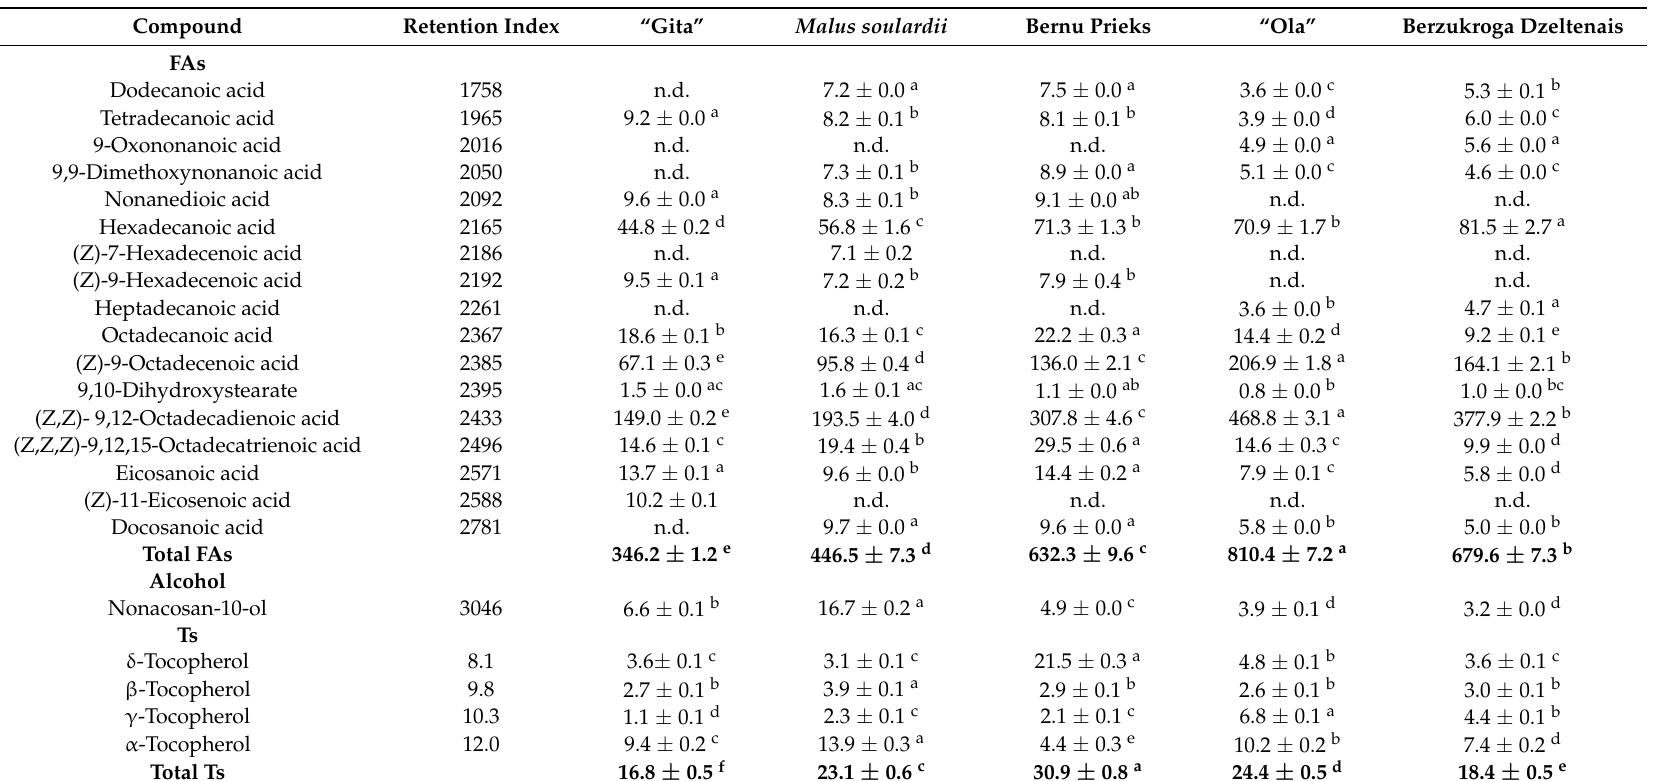
Table 1. Content of fatty acids (FAME derivatives) and tocopherols (Ts) in pomace oils recovered from Malus spp. crab apples, mg mL − 1